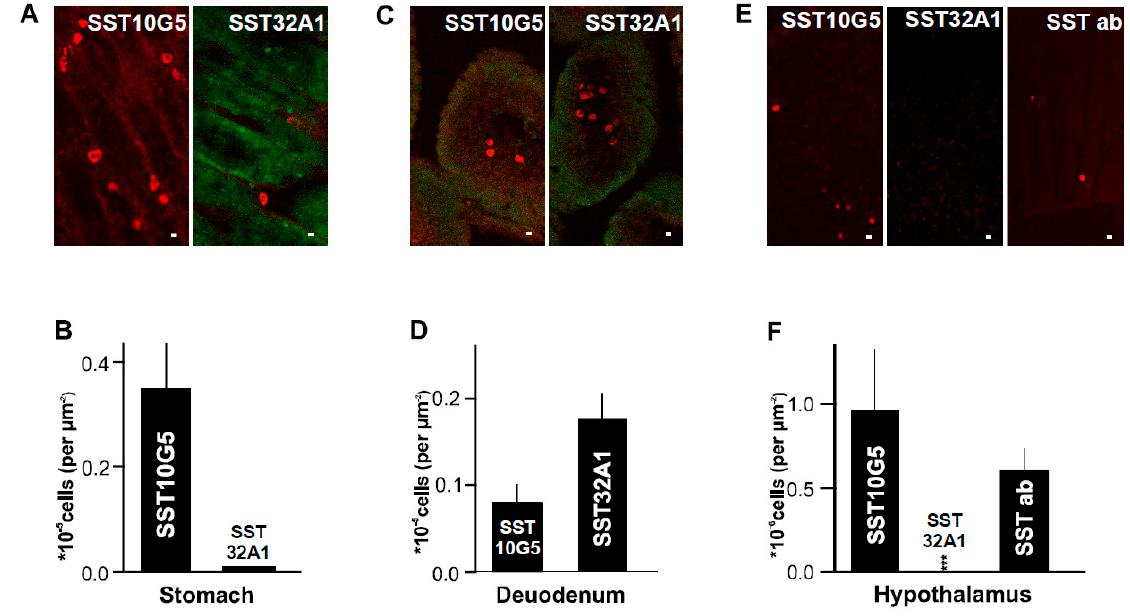
Figure 4. SST-14 expression in the hypothalamus and gut tissues—( A ) Images showing a cryo-section of mouse stomach stained with SST10G5 or SST32A1 (Scale bar = 1 µm), ( B ) Number of cells in image ( A ) labelled with SST10G5 or SST32A1 in the stomach tissues. Each experiment was repeated on two different days using 3–4 mice. At least 6 sections were analysed in each case, ( C ) Image showing a cryo-section of mouse duodenum stained with SST10G5 or SST32A1 (Scale bar = 1 µm), ( D ) Number of cells in image ( C ) labelled with SST32A1 or SST10G5 in the duodenal tissues. Each experiment was repeated on two different days using 3–4 mice. At least 6 sections were analysed in each case, ( E ) Image showing a cryo-section of mouse hypothalamus stained with SST10G5 or SST32A1 or commercialy available SST14 antibody (SST ab) (Scale bar = 1 µm), ( F ) Number of cells in image ( E ) labelled with SST10G5, SST32A1 or commercially available SST14 antibody (SST ab) in the hypothalamus. Each experiment was repeated on two different days using 5–6 mice. At least 5 sections were analysed in each case. (*** p <